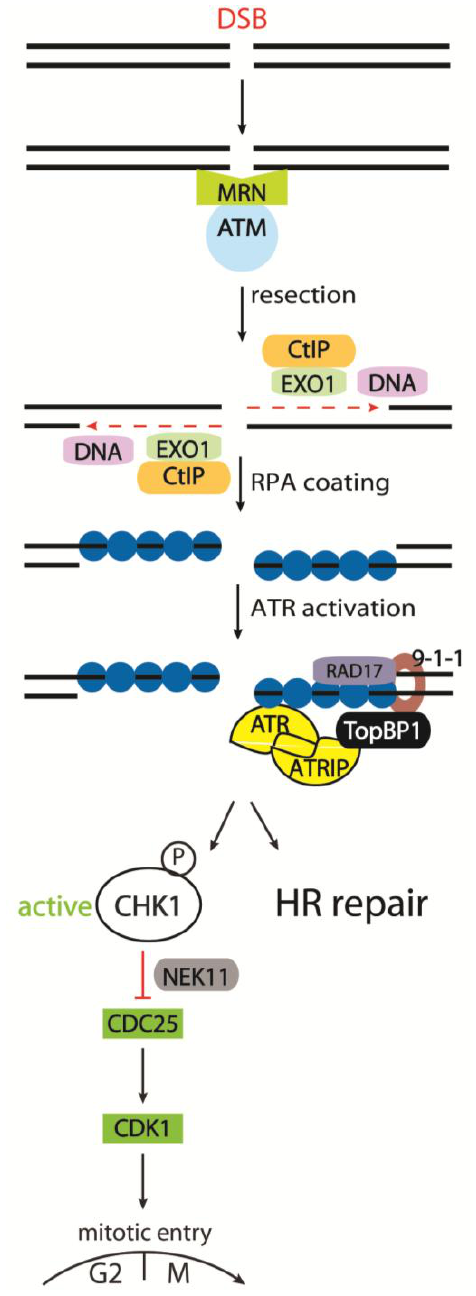
Figure 1. Activation of checkpoint regulator (CHK1) in response to DNA Double Strand Breaks ( DSBs). The MRN complex detects DSBs and recruits Ataxia Telangiectasia Mutated (ATM) to initiate checkpoint signaling. During the S and G2 phases of the cell cycle, dsDNA resection can be performed by the nucleases DNA2 and EXO1, together with CtIP. The resulting ssDNA is coated by Replication Protein A (RPA), and is prepared for homologous recombination (HR) repair. Furthermore, ssDNA-coated by RPA recruits the ATR/ ATR interacting protein (ATRIP) complex as well as TopBP1 via the 9-1-1 complex, enabling full ATR activity. ATR then activates a subset of targets, including CHK1. CHK1 can phosphorylate CDC25A in response to DSBs, targeting CDC25A for proteasomal degradation. Since CDC25A is required for CDK1 activity to facilitate mitotic entry, cells arrest in the G2 phase upon CDC25A